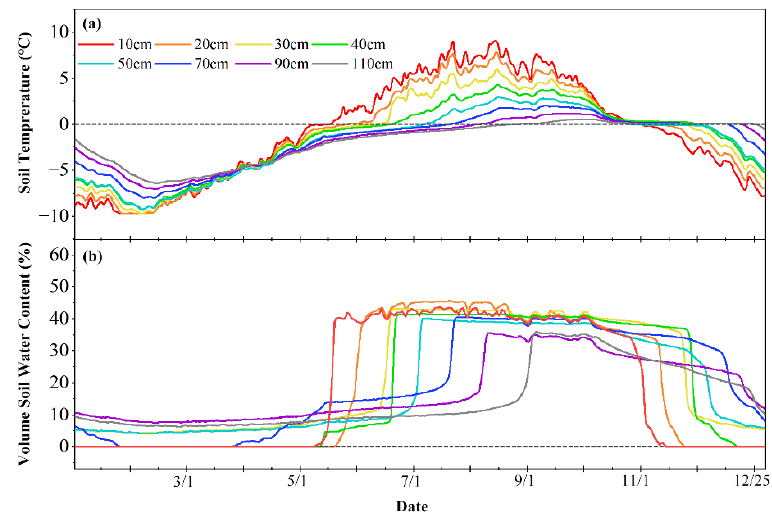
Figure 3. Variations in the ( a ) soil temperature (ST) and ( b ) volumetric soil water content (VSWC) at depths of 0.1 to 1.1 m, respectively.